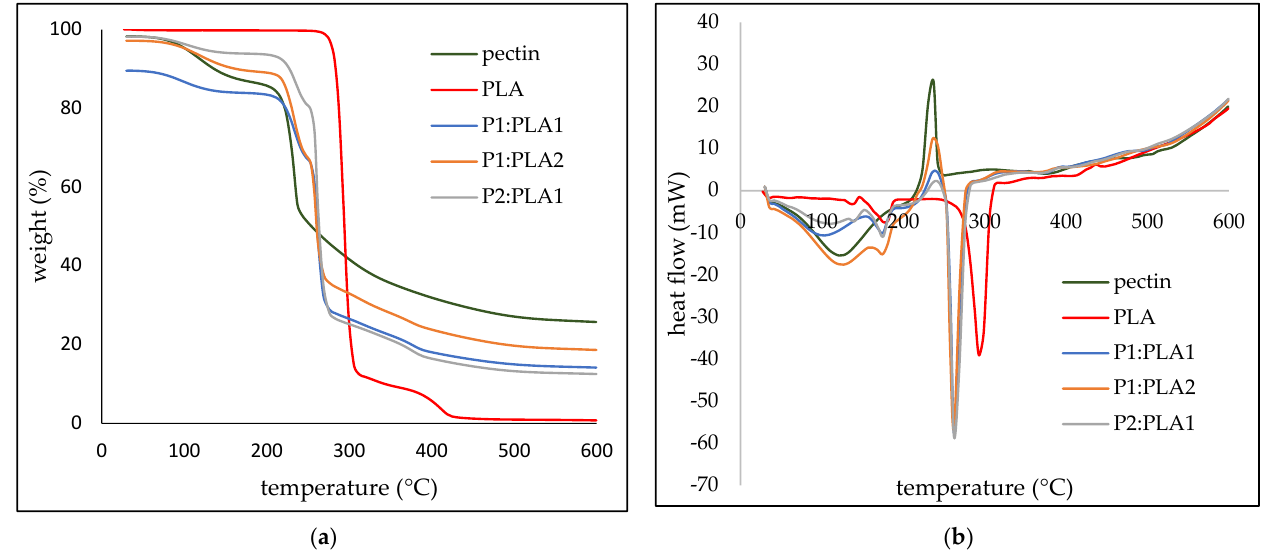
Figure 4. ( a ) TG and ( b ) DSC of the prepared hybrid and reference materials. The TG and DSC of indomethacin and diclofenac sodium are shown in Figure S3, where it is shown that the melting of the indomethacin occurs at 160 °C, and the degrada- tion starts at around 140 °C. The DCF shows a characteristic exothermic peak at around 288 °C, followed by an endothermic peak at around 310 °C. The degradation of DCS starts at around 290 °C, with 45% mass loss at 600 °C. The amount of pectin in the hybrid samples was determined through TG curves. The determined values of weight percent of pectin in the hybrid samples were 60.8%, 73.8%, and 49.1% for P1:PLA1, P2:PLA1, and P1:PLA2, respectively (Table 2).